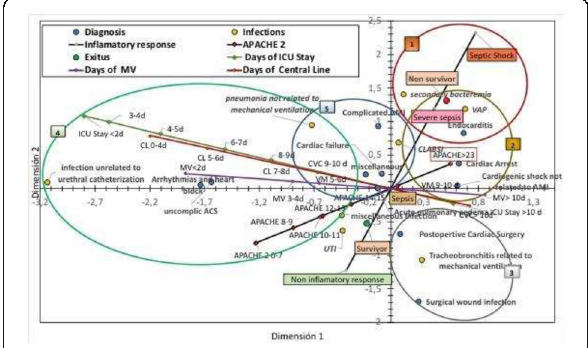
Fig. 2 (abstract 0071). CATPCA Model 2. Only patients with infection.The inflammatory response has been